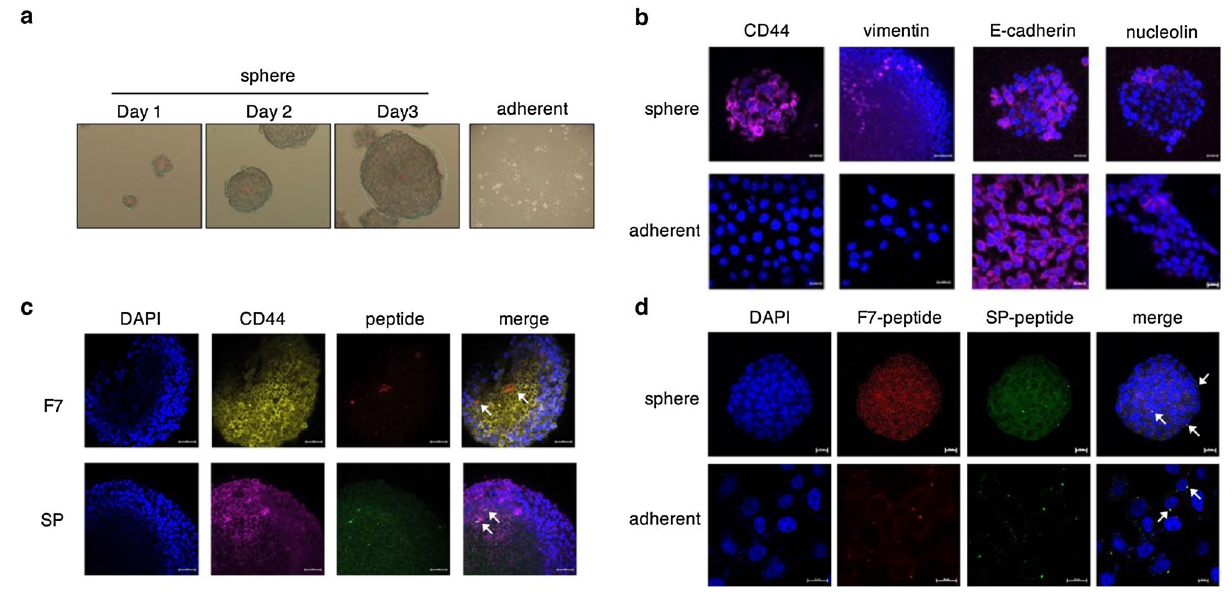
Figure 2. Expression of CSC markers corresponding to peptide binding. ( a ) Phase-contrast photomicrographs of the spheres cultured from SAS-E2-crimson-P2A::ttksr39 cell line using the ultra-low attachment plate. Right panel: adherent cells. magnification, 100×. ( b ) ICC results showing the expression of representative CSC marker, CD44 and EMT markers, vimentin and nucleolin in spheres (upper panel) and adherent cells (lower panel). E-cadherin is an epithelial cell marker. ( c ) The peptide binding to tumor spheres which highly expressed CD44. The arrow indicates the presence of F7 and SP peptide. Red: Lissamine Rhodamine labeled F7 peptide, Green: FITC labeled SP peptide, Blue: DAPI; Scale bar, 20 μm. ( d ) Comparison of peptides binding to spheres and adherent cells. Yellow: